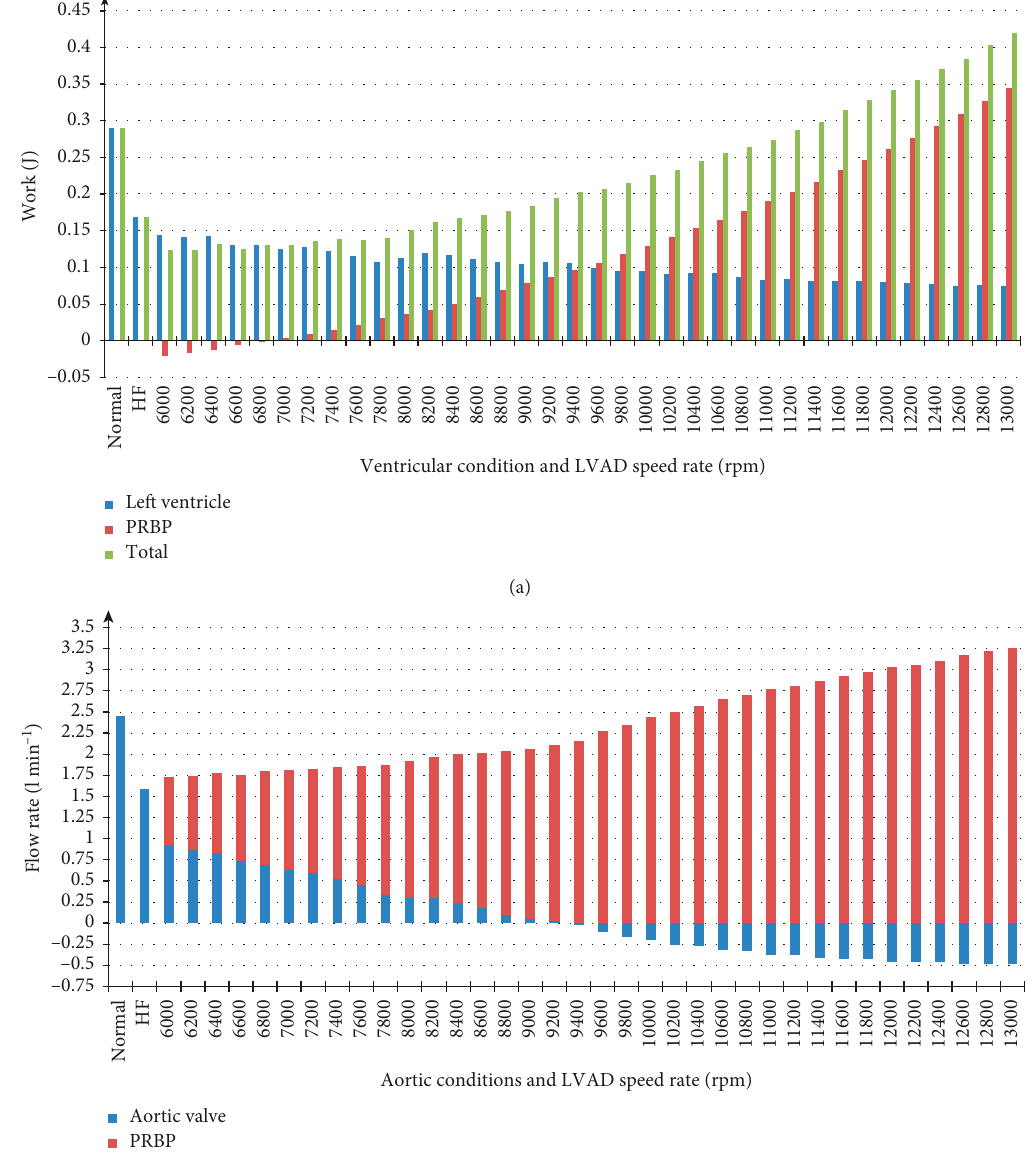
Figure 7: (a) Average levels of left ventricle work, PRBP work, and total work for simulated state of acute heart failure in 2-year-old pediatric patient with mass of 15.2kg in the pump speed range of 6000–13000rpm with 200rpm step. Levels of left ventricle work in normal and heart failure states are also represented for comparison. (b) Average aortic valve and pump flow rates with respect to normal state, heart failure, and states in the pump speed range